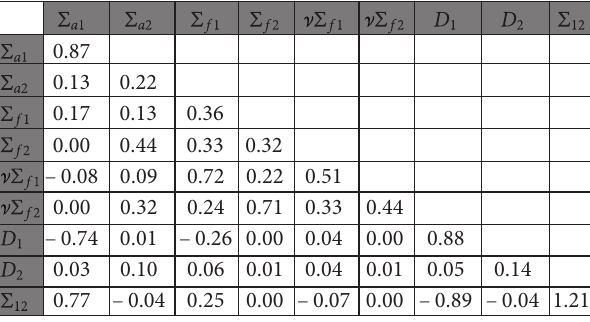
Figure 6: TMI HFP covariance matrix.